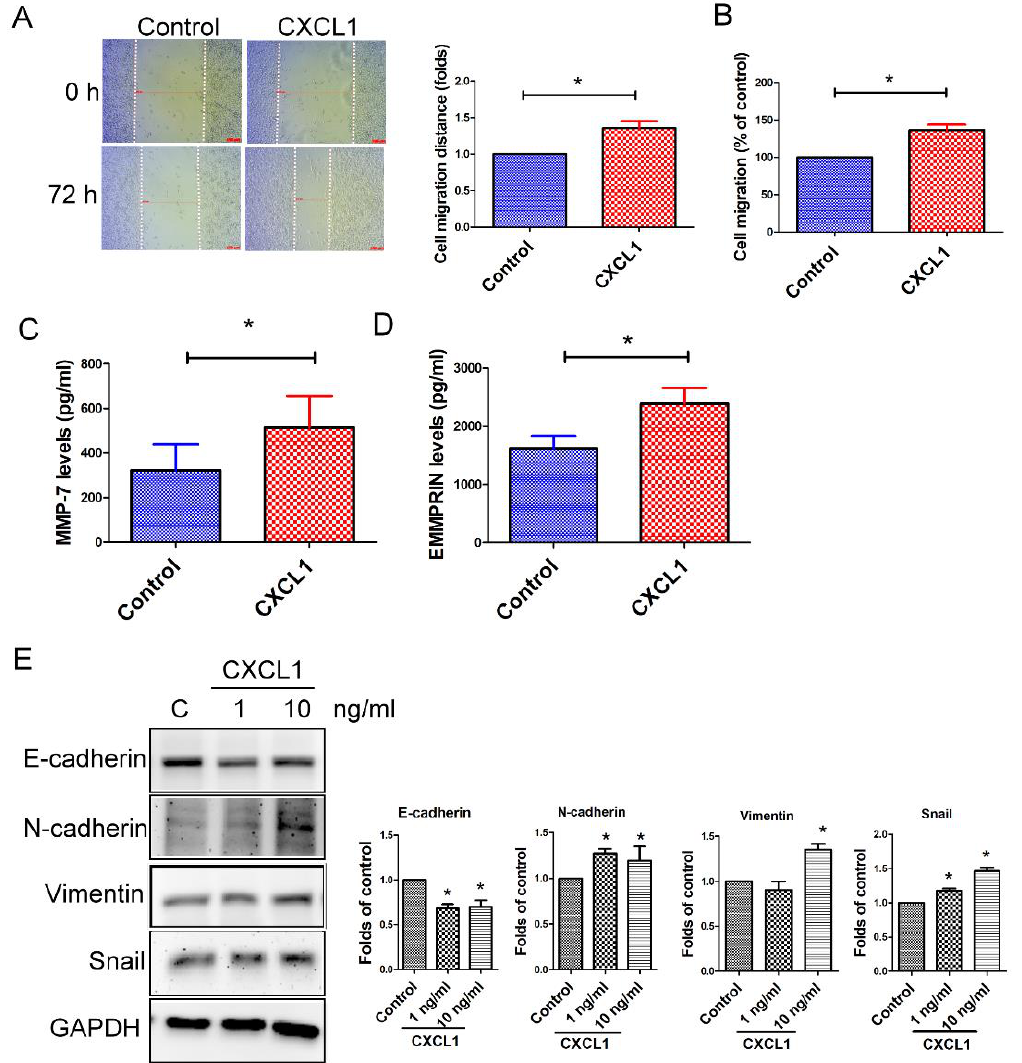
Figure 4. CXCL1 enhanced cancer progression in SW620 cells. CXCL1 increased cell migration, as determined by wound healing ( A ) and transwell ( B ) analysis. The migration ability of SW620 cancer cells was assessed by wound healing assay and transwell assay. CXCL1 acted as a chemoattractant for cancer migration in the transwell system for 24 h. The effect of CXCL1 on the expression of MMP-7 ( C ), EMMPRIN ( D ) and epithelial-to-mesenchymal transition (EMT) ( E ) in SW620 cells. SW620 cells were treated with CXCL1 for 24 h, and the levels of various MMPs and EMT markers were determined by Luminex assay and Western blot. Results are representative of at least three independent experiments. Each value is the mean ± SD of three determinations. * Significant difference between the two test groups ( p < 0.05)